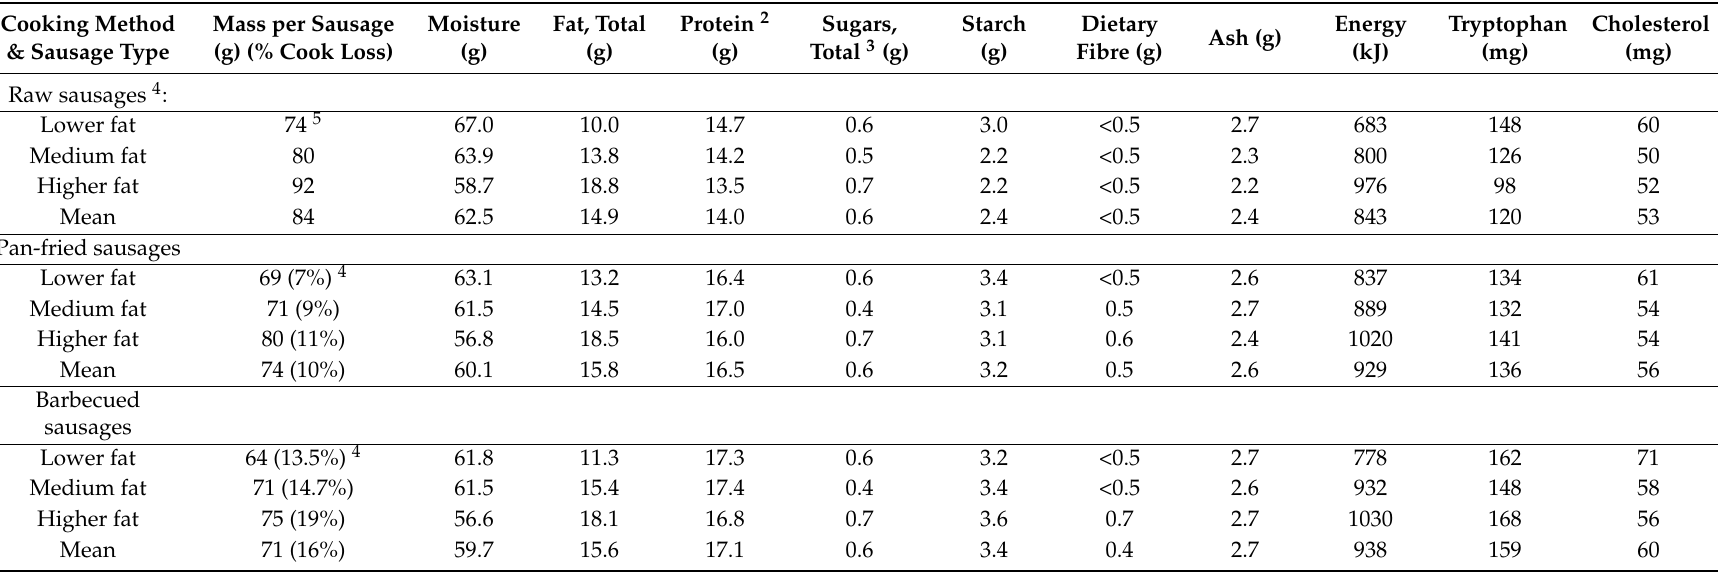
Table 4. Proximate composition, energy, tryptophan and cholesterol content, per 100 g edible portion, of composite samples 1 of beef sausages grouped according to fat content; raw, pan-fried without oil and barbecued without